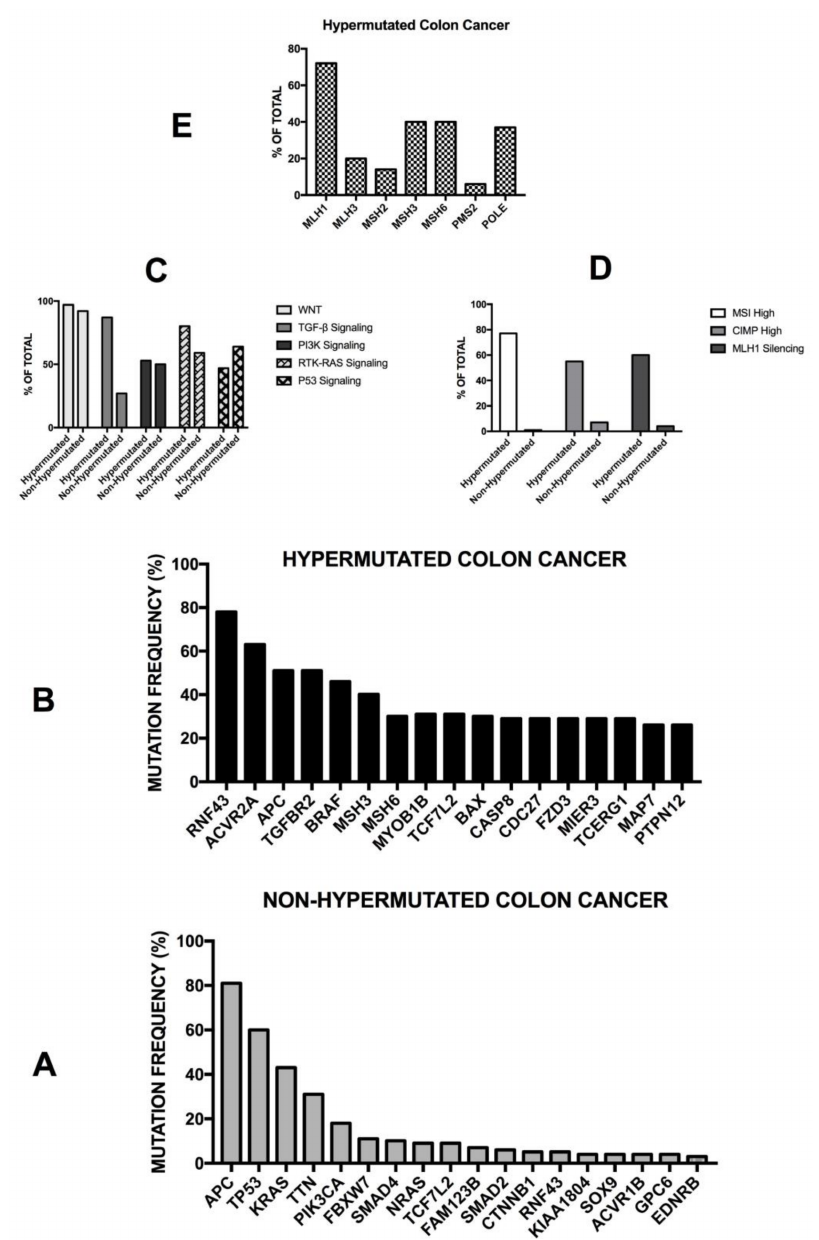
Figure 4. Genes most frequently mutated in colorectal cancer. ( A ) Frequently mutated genes in non-hypermutated colon cancer. ( B ) Recurrently mutated genes in hypermutated colon cancers. ( C ) Frequency of signaling pathway alterations observed in hypermutated and non-hypermutated colorectal cancers. ( D ) Frequency of microsatellite instability (MSI-High), CpG island methylator phenotype (CIMP-High) and MLH1 gene epigenetic silencing in hypermutated and non-hypermutated colorectal cancers. ( E ) Mutations in mismatch repair genes and POLE among the hypermutated colorectal cancers. The figure shows the data reported in the The Cancer Genoma Atlas (TCGA) study